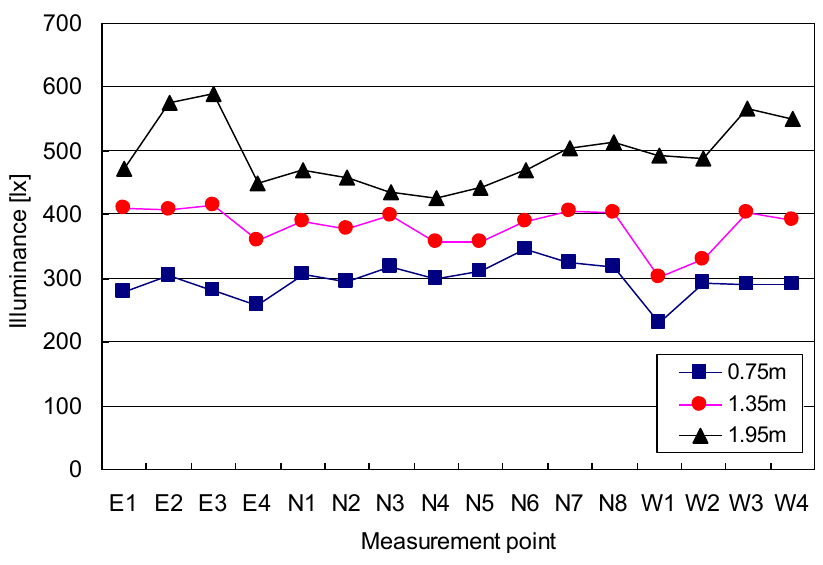
Figure 7. Variation of illuminance on walls (750 lx condition).